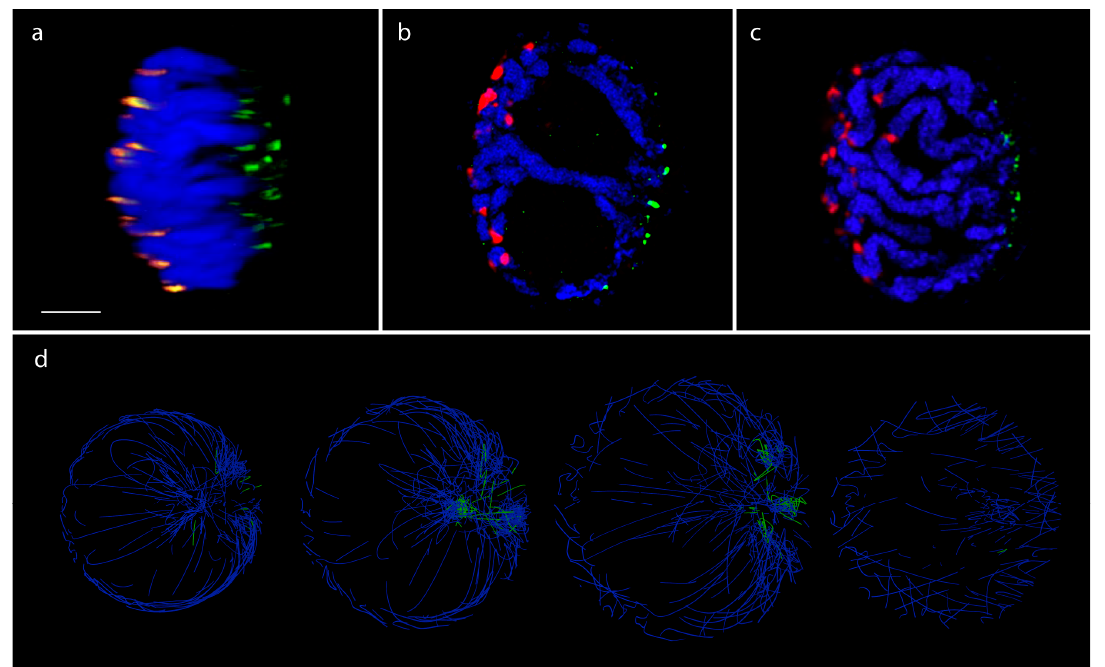
Figure 6. In situ and in silico. Fluorescence in-situ hybridization (FISH) showing centromeres (orange, red) and telomeres (green) on a 3D-fixed barley mitotic nucleus. Barley centromeres are labelled by the barley centromere-specific G+C repeat probe (red) while telomeres are visualized by the plant telomeric repeat sequences (TRS) used as a probe (green). Chromosomes are counterstained with DAPI. Bar = 5 μ m. ( a ) Side view of a 3D-rendered z-stack captured from a barley mitotic nucleus. ( b , c ) FISH on individual image frames of a barley mitotic nucleus showing polarized centromere-telomere arrangement and chromosome arms laying parallel with the telomere-centromere axis. ( d ) In silico, cross-section images of the pseudo-structure of Barley genome. Green indicates telomeric regions. A well-distinguished nucleolus-like region is visible inside the spherical topology. Telomeres are clustered on one side of the spherical